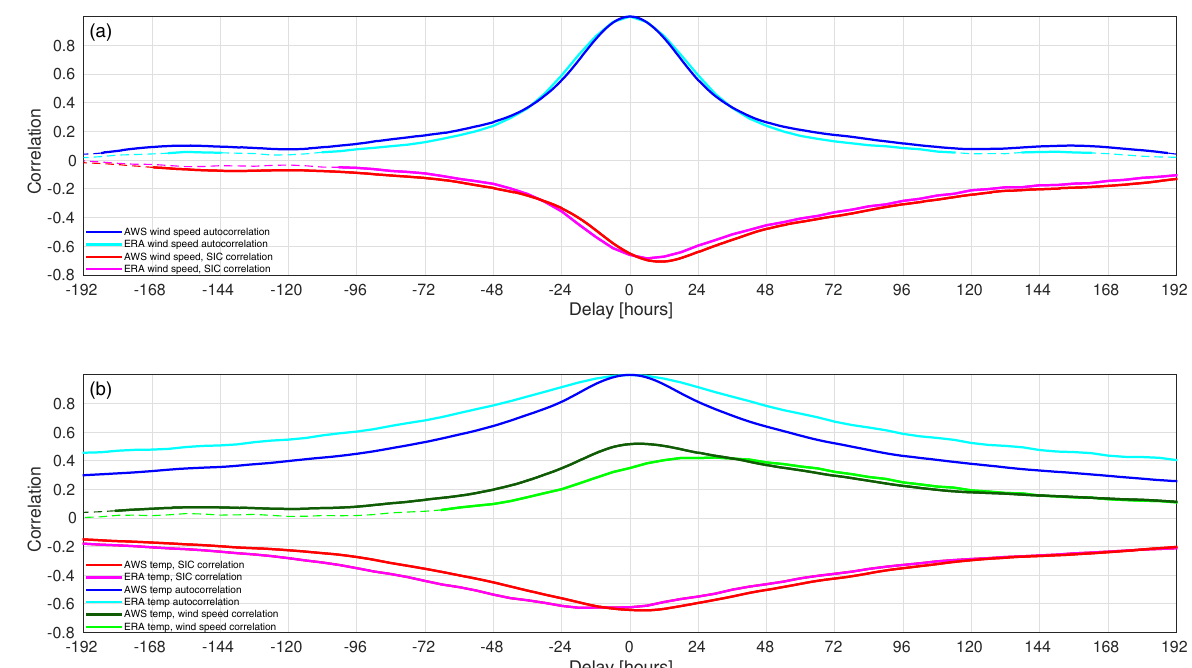
Figure 4. (a) Cross-correlation curve for sea ice concentration and AWS (red) and ERA-Interim (magenta) wind speeds and autocorrelation curve for wind speed at Laurie II AWS (blue) and ERA-Interim (cyan). (b) Cross-correlation curve for sea ice concentration and temperature for AWS (red) and ERA-Interim (magenta); autocorrelation curves for wind speed at Laurie II AWS site (blue) and ERA-Interim (cyan) are also shown. Cross correlation for wind speed and temperature measured at Laurie II AWS (dark green) and ERA-Interim (light green). Dashed lines indicate significance p > 0 . 01. The delay is defined such that positive indicates meteorology measures leading